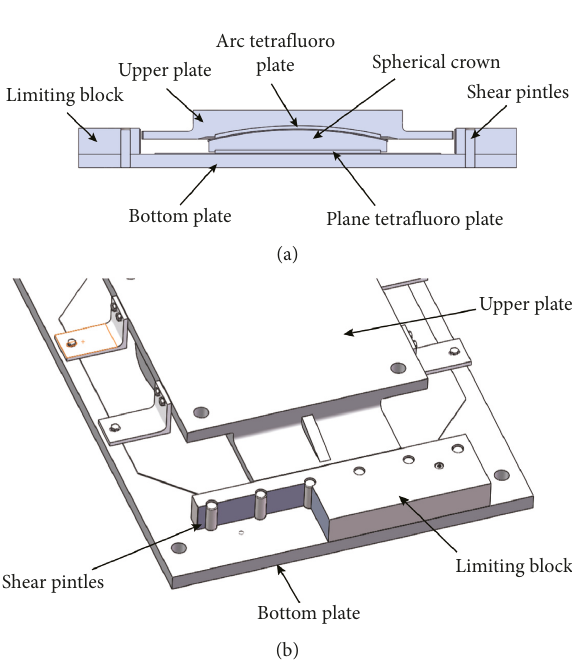
Figure 4: (a, b) Configuration of the isolation bearing.